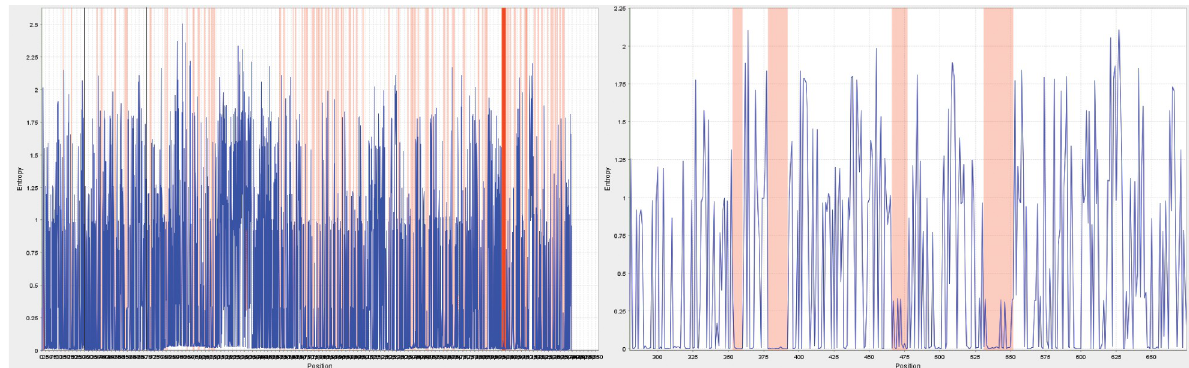
Fig 1. Conservation analysis of dengue envelope protein. Conservation analysis of complete sequence of dengue virus is shown in left panel, where x axis is representing sequence position and y axis is informational entropy at any particular position. Red colour represents conserved region in dengue virus genome. Dengue envelope protein is spanning from 280 to 674 position that is selectively shown in right panel.